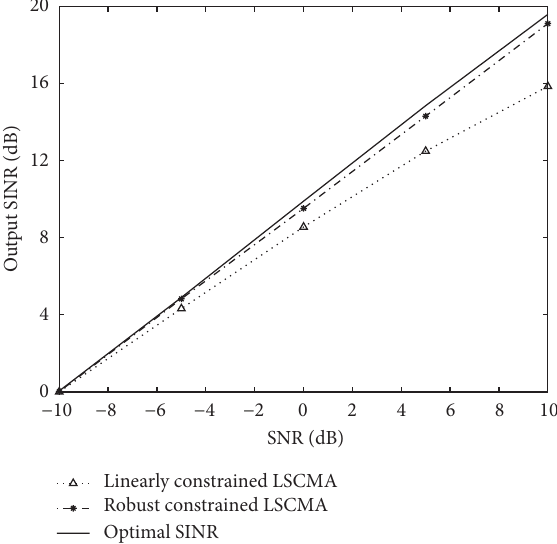
Figure 6: Output SINR versus SNR (in no mismatch case).